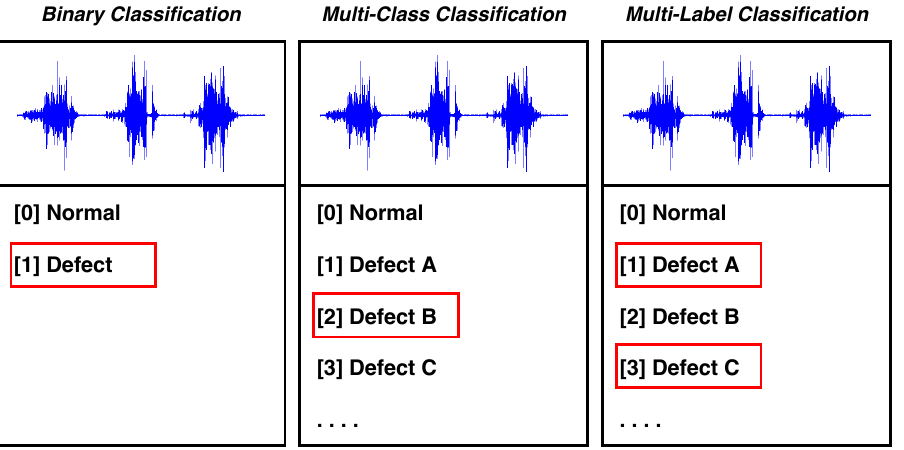
Figure 5. Types of